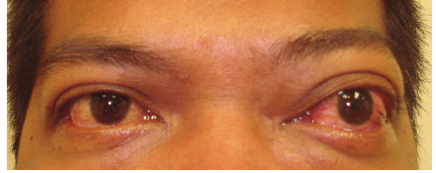
Figure 1: Congestive nonpulsating exophthalmos of the left eye.